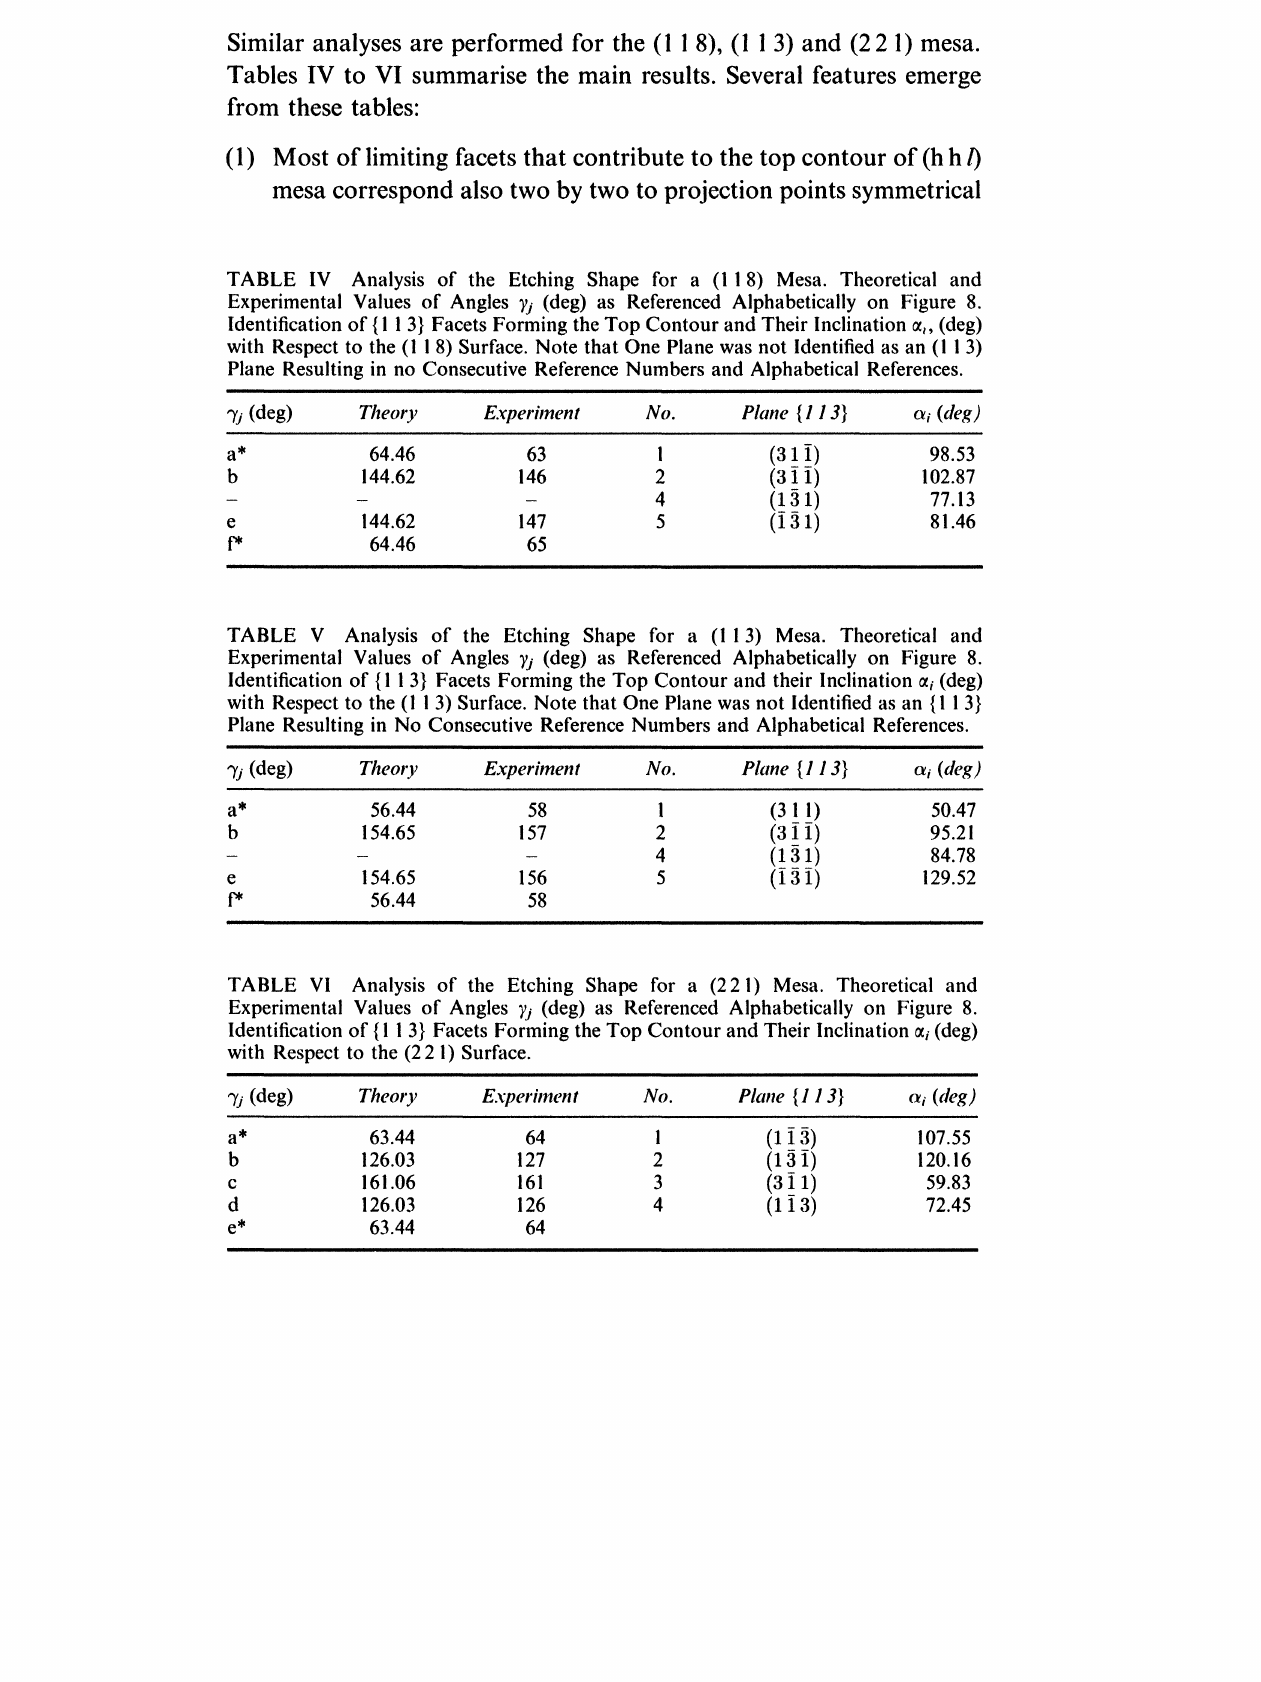
TABLE Vl Analysis of the Etching Shape for a (22 l) Mesa. Theoretical and Experimental Values of Angles ), (deg) as Referenced Alphabetically on Figure 8. Identification of 3} Facets Forming the Top Contour and Their Inclination i (deg) with Respect to the (2 2 I)